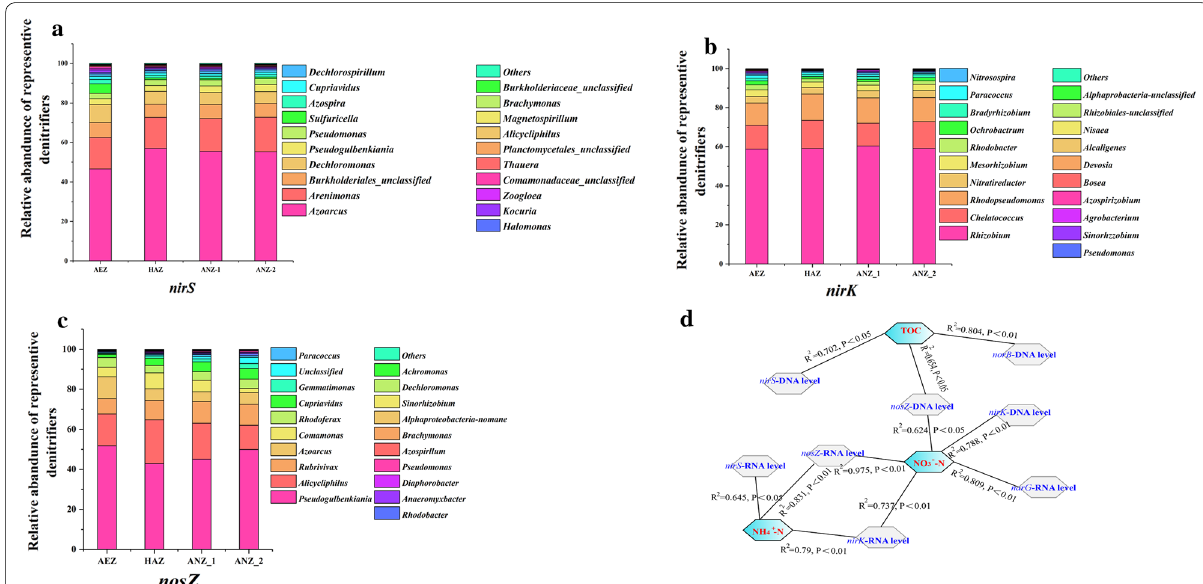
Fig. 4 Community structures in different layers of sediments based on sequence analysis of nirS ( a ), nirk ( b ) and nosZ ( c ). d Pearson correlation matrix between DNA abundance, RNA transcriptional level of denitrification genes and sediment physicochemical factors. AEZ aerobic zone, HYZ hypoxic zone, ANZ-1 up-anoxic zone, ANZ-2 sub-anoxic